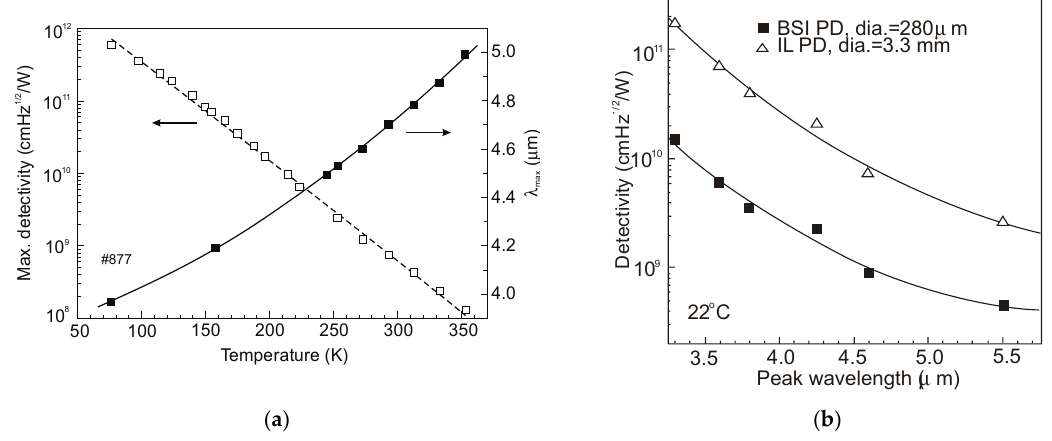
Figure 39. Detectivity of InAsSb DH photodiodes: ( a ) maximum detectivity and peak wavelength versus temperature (after [123]); ( b ) peak detectivity versus peak wavelength of photodiodes without (BSI) and with Si lenses (IL) (after [121]).